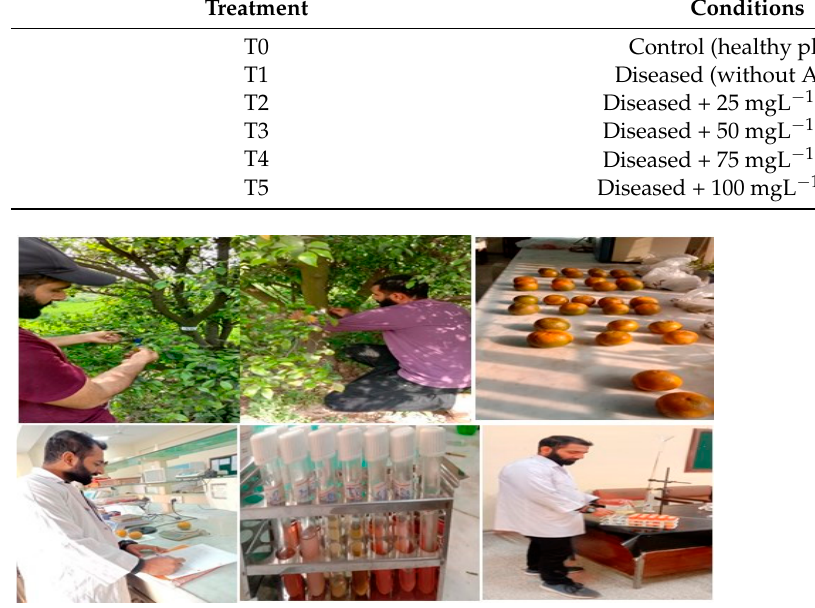
Figure 11. Showing the sample collection and evaluation of fruit parameters.